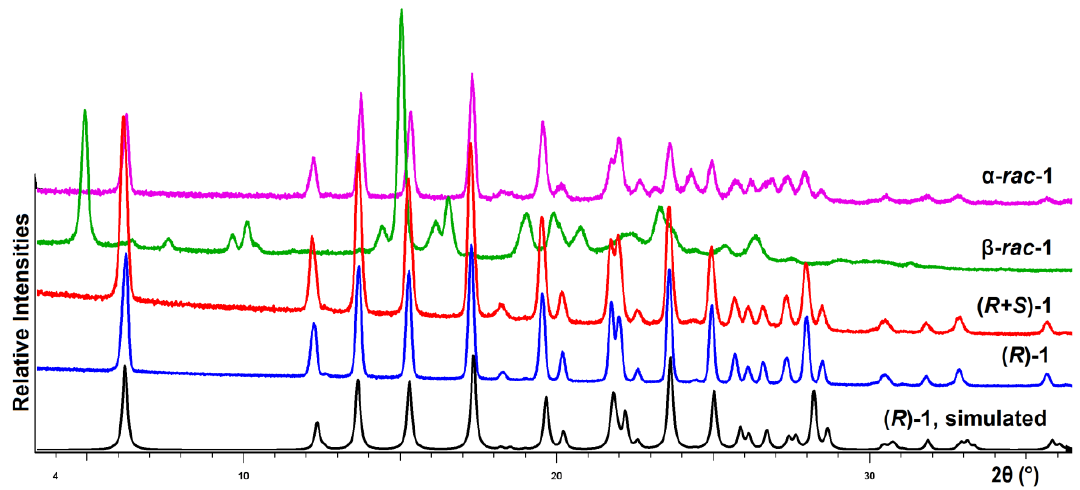
Figure 6. Comparison of experimental powder X-ray diffraction (PXRD) patterns of ( R )- 1 , ( R + S )- 1 , α - rac - 1 , and β - rac - 1 forms and simulated PXRD patterns of ( R )- 1 forms.